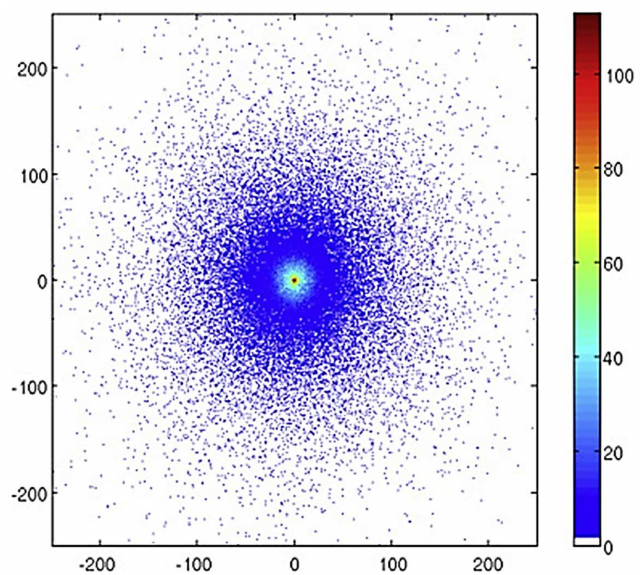
Figure 8. Number of photons emitted per mm 2 attributed to the 337 nm emission in a 500 × 500 mm area as observed from above a 60 Co source dispersed over a 2 cm radius circle on an aluminium surface. The ticks give the x and y positions in mm. Reprinted from [20] with permission from Elsevier.